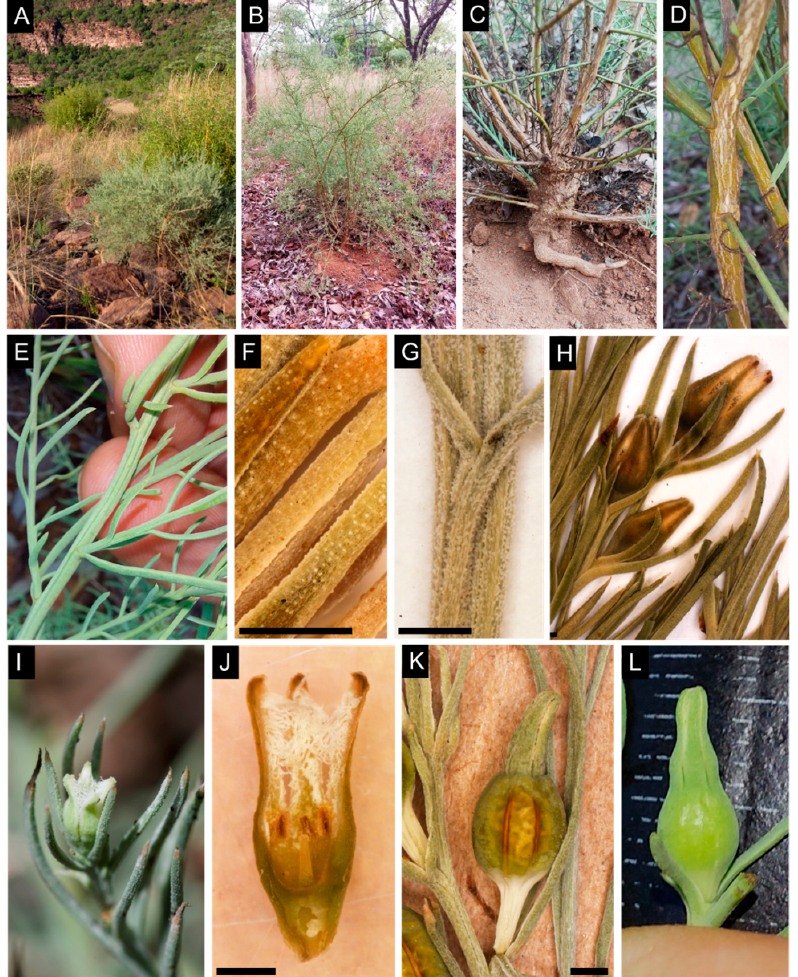
Figure 3. Thesium celatum . ( A ) Habitat. ( B ) Habit. ( C ) Woody rootstock. ( D ) Woody stem. ( E ) Sulcate herbaceous upper branches. ( F , G ) Variation in indumentum from nearly glabrous to densely ver- ruculose. ( H ) Few-flowered spike-like inflorescence. ( I ) Solitary flower with involucral bracts. ( J ) Cross-section of a rehydrated flower showing the anthers inserted in the upper half of the hy- panthium and the stigma reaching to the lower half of the anthers. ( K ) Dry fruit with longitudinal and reticulate veins, and a prominent stipe. ( L ) Fresh fruit without venation and lacking a stipe. The scale bars represent 1 mm. Photographs taken by L. Willemse ( A , I ), N. Lombard ( F – H , J – K